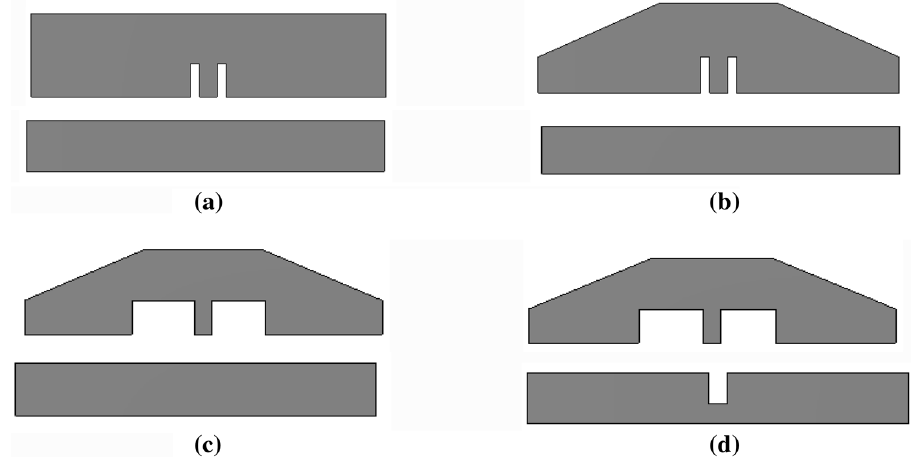
Figure 3. Evolution stages of the wristband antenna ( a ) antenna 1, ( b ) antenna 2, ( c ) antenna 3 and ( d ) antenna 4.